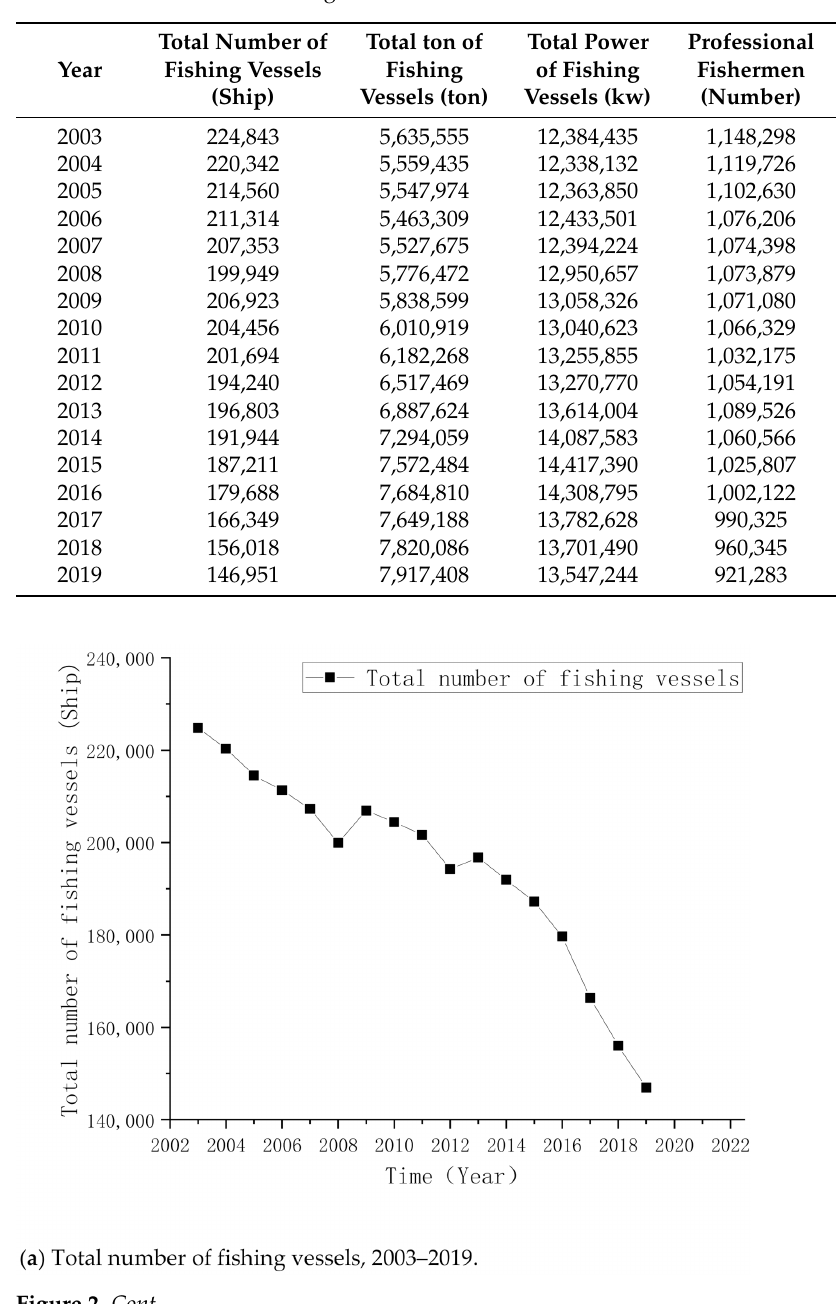
Table 2. China’s offshore fishing data from 2003 to 2019.